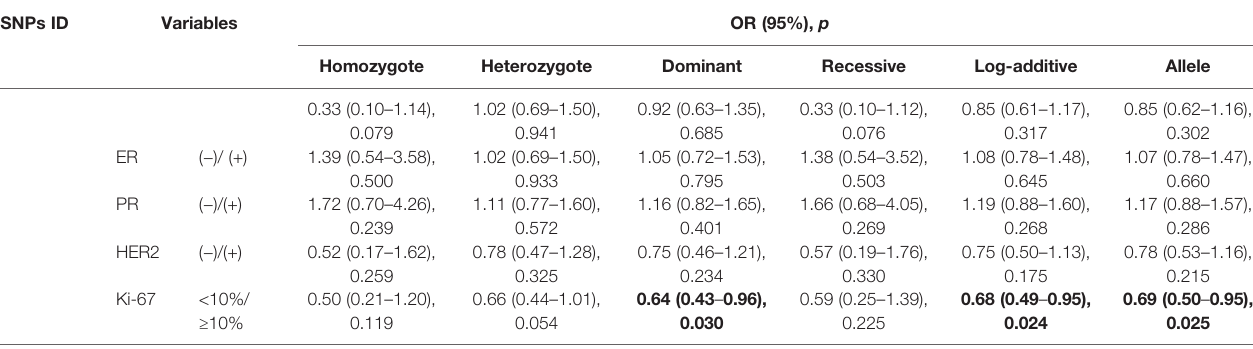
Figure 2 . Table 6 showed that rs1907168 was the best single- locus model to predict the risk of BC (testing accuracy = 0.5048, CVC = 8/10, p = 0.0298). The best multi-loci model included rs112276562, rs1907168, and rs6551130 (testing accuracy